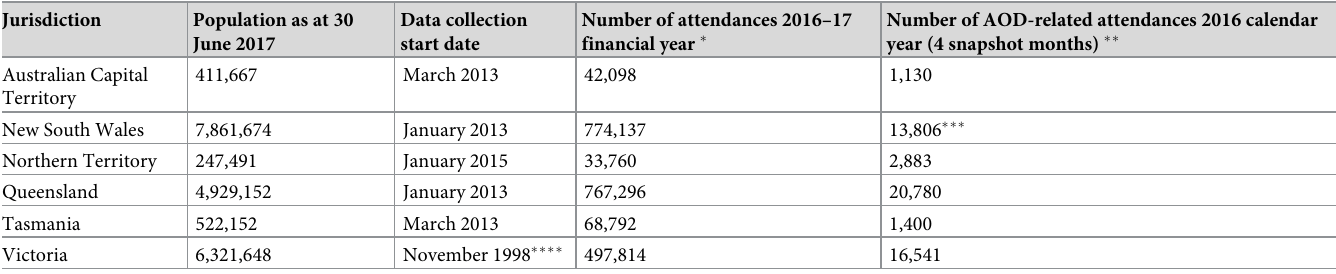
Table 1. Summary of coded data availability by